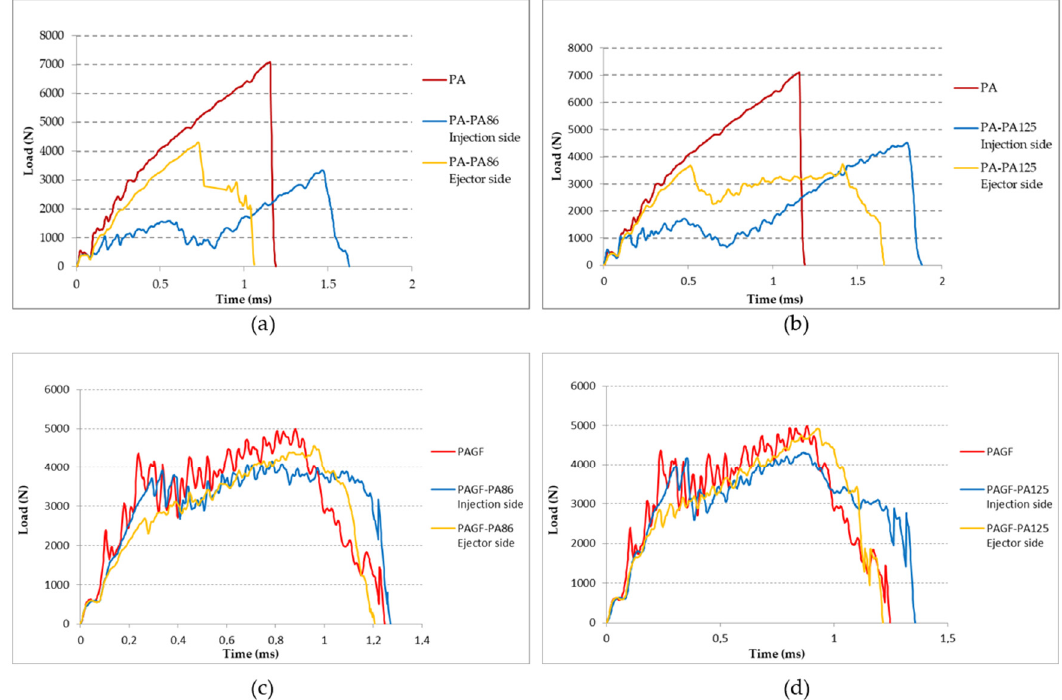
Figure 12. Comparison of the impact test according to the impact side on the composite sample and with respect to the matrix material without reinforcement. ( a ) PA matrix and PA-PA86 composite. ( b ) PA matrix and PA-PA125 composite. ( c ) PAGF matrix and PAGF-PA86 composite. (d ) PAGF matrix and PAGF-PA125 composite.